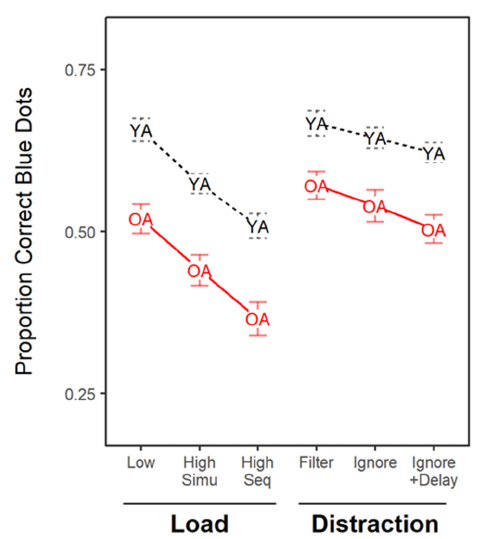
Figure 3. Proportion of correctly recalled blue dots in Experiment 1 for each age group (YA = younger adults, OA = older adults) across the experimental conditions that varied in memory load (Low, High-Simultaneous, and High-Sequential) and distractor presence (Filter, Ignore, and Ignore+Delay).